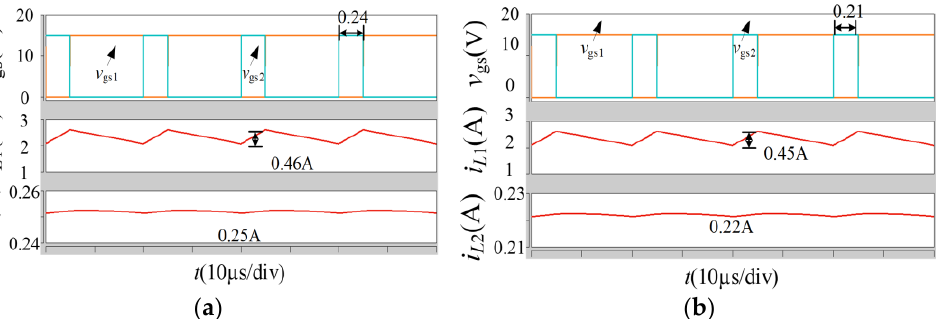
Figure 11. The stable simulation waveforms of i L1 , i L2 in step-down mode: ( a ) V 1 = 400 V; ( b ) V 1 = 450 V.